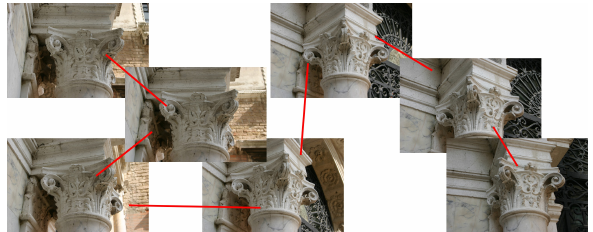
Figure 2. Comparison between couple of images